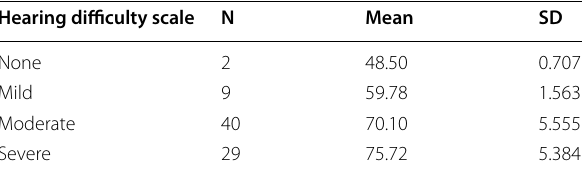
Table 1 Mean of the SADL satisfaction score obtained by